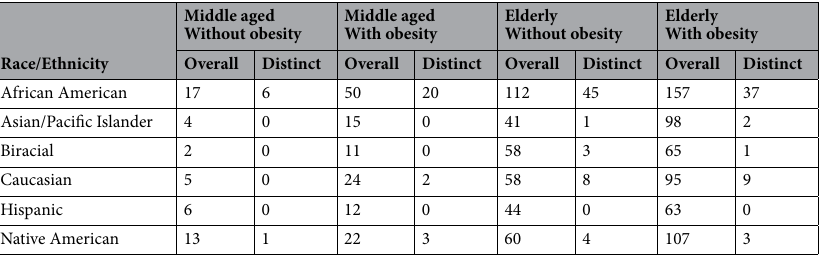
Table 2. The number of multimorbidity patterns by race/ethnicity at 5% threshold across weight